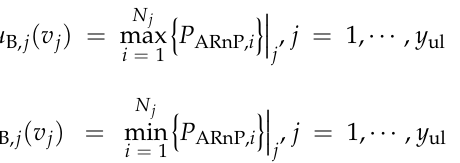
represents the speed value of the